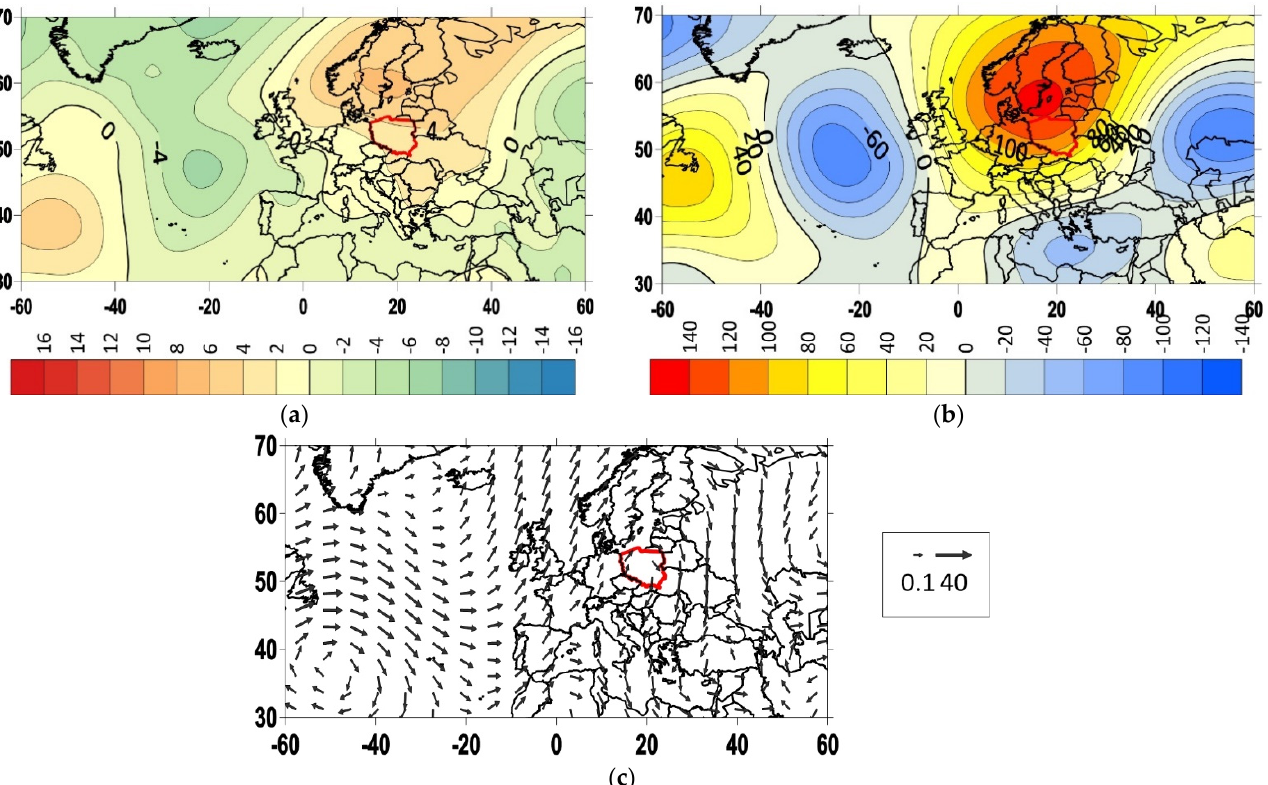
Figure 8. Average fields for the 1994 heat wave: ( a ) anomalies of SLP; ( b ) anomalies of HGT700 mb; ( c ) wind at 700 hPa level. The red line marks the borders of Poland.